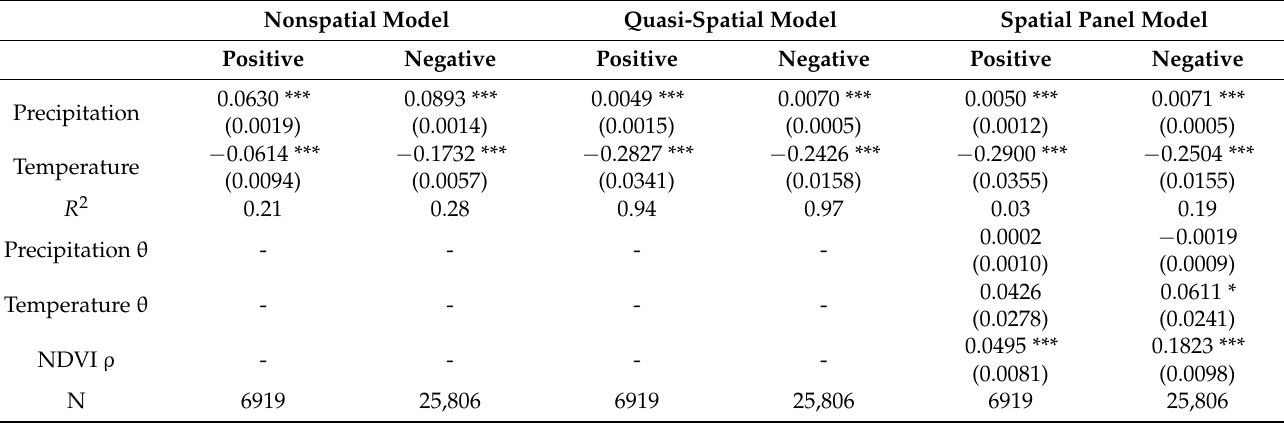
Table 1. Coefficients and associated standard errors of the nonspatial OLS, quasi-spatial OLS, and spatial Durbin panel data model, run separately for pixels exhibiting significant negative and positive directional persistence. The nonspatial model includes only time FE, while the quasi-spatial and spatial Durbin models include both time and location